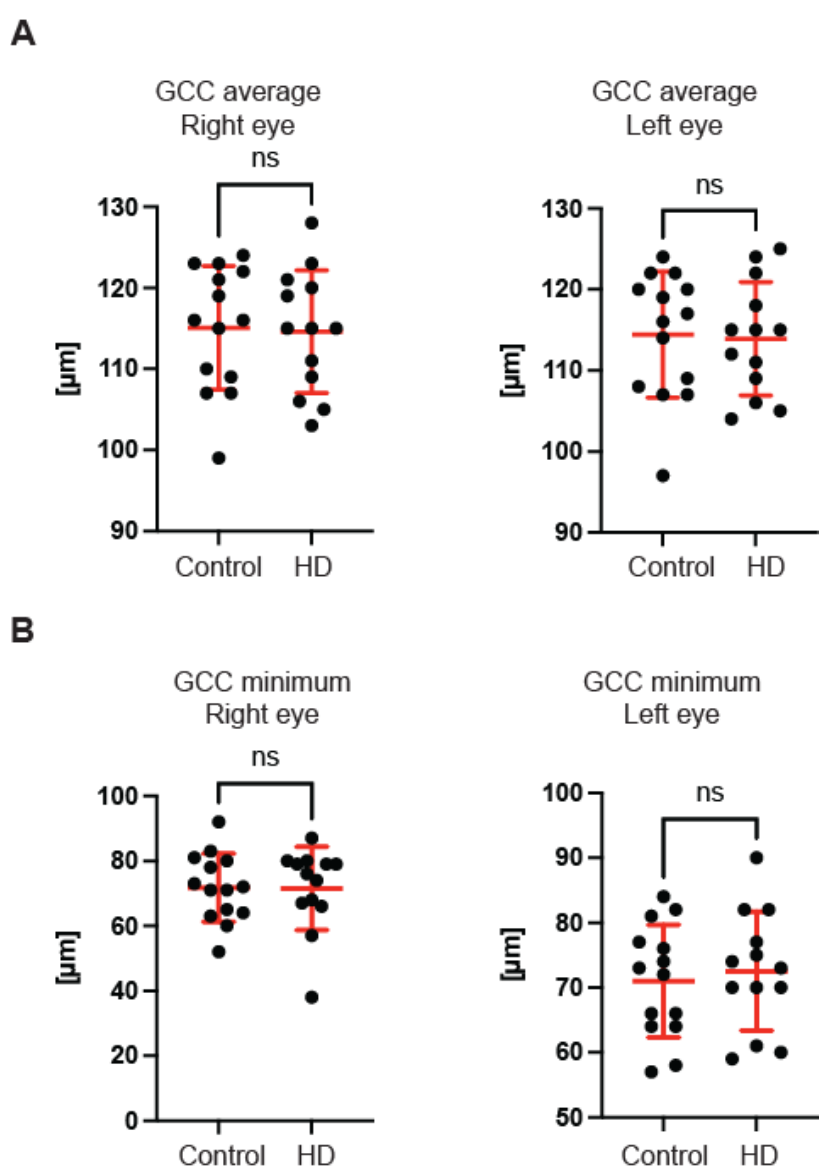
Figure 3. Optical coherence tomography of the ganglion cell complex (GCC) in HD gene carriers and healthy individuals. ( A ) The average ( A ) and minimum ( B ) GCC parameters consisting of three innermost retinal layers: the nerve fibre layer, the ganglion cell layer and the inner plexiform layer. Error bars are ± SD ( n > 13). One-way ANOVA with Bonferroni post hoc test. ns—non specific.